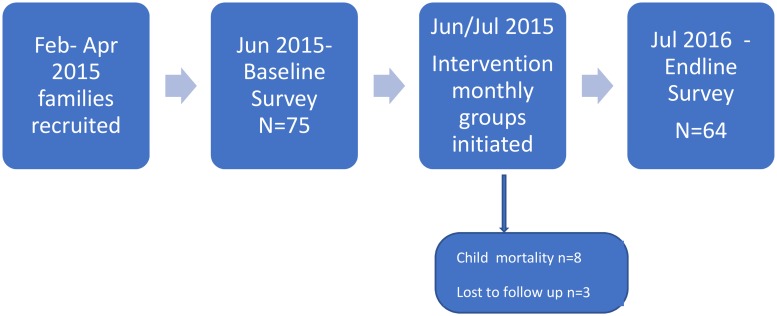
Pre/Post evaluation design pathway.